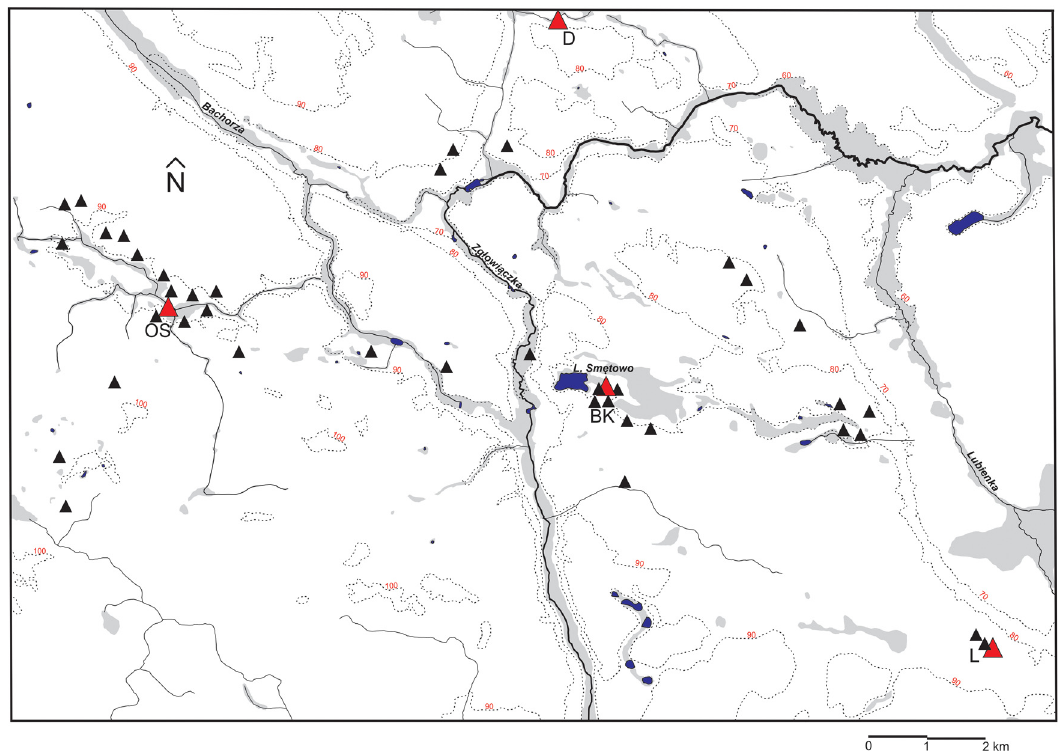
Figure 3: Hamlets of the Brze ść Kujawski Group around Brze ść Kujawski. Key: OS – Os ł onki - Miechowice - Konary ( OMK ) hamlet; BK – Smétowo hamlet centered on Brze ść Kujawski and including sites at Pikutkowo and perhaps Smólsk; L – suggested hamlet consisting of longhouses at Ludwinowo sites and Kruszynek; D – suggested hamlet at Dubielewo, possibly extending to Bodzia about 5 km to the